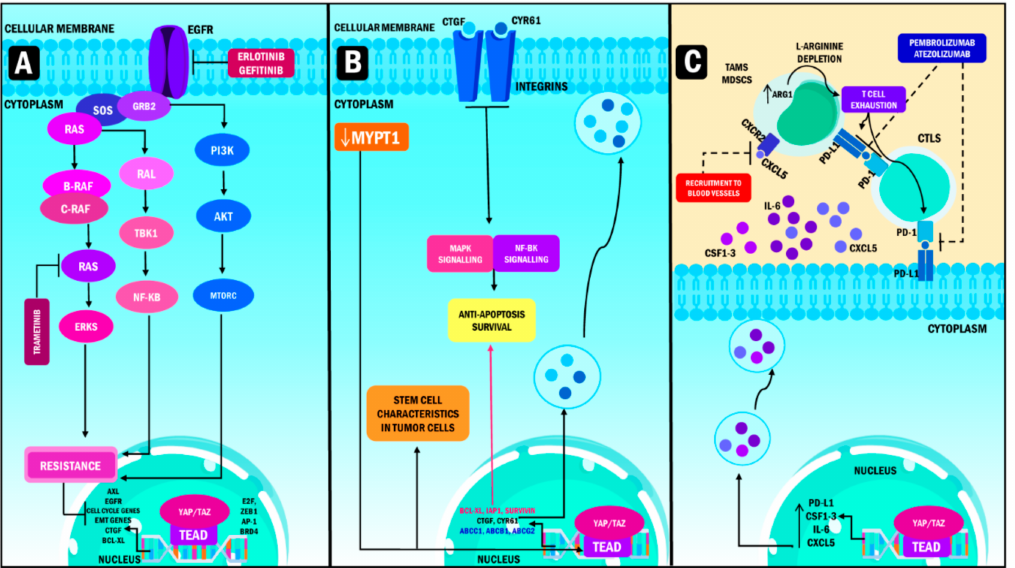
Figure 4. YAP/TAZ role in oncotherapy resistance. ( A ) Targeted therapy resistance. YAP/TAZ resistance to targeted therapy occurs mainly in EGFR and MAPK inhibitors, in non-small cell lung adenocarcinoma takes place thanks to the induction of high transcription levels of AXL. Meanwhile, YAP promotes resistance to MEK1/2 inhibition in neuroblastomas, with a hyperactive signaling of the RAS gene in cells treated with trametinib. Consequently, the overexpression of YAP produces transcription of genes that stimulate cell cycle entry, EMT, survival and cell death evasion, thus increasing resistance. ( B ) Chemotherapy resistance. The main mechanism used by YAP/TAZ to induce chemotherapy resistance is by binding to TEA domains, which produces the activation of the promoters of the Cyr61/CTGF oncogenes, causing resistance, evasion of apoptosis and hypoxia when overexpressed on the surface of tumor cells in breast cancer. In juxtaposition, the downreg- ulation of MYPT1 produces the activation of the transcriptional module of the Hippo pathway, enhancing resistance to chemotherapy and the emergence of CSC phenotypes in ovarian cancer. ( C ) Immunotherapy resistance, PD-L1, CSF1-3, IL-6 and CXCL5 transcription create an enhanced immunosuppression activity by inhibiting monoclonal antibodies whose target is PD-L1. Subse- quently, this phenomenon leads to the suppression of cytotoxic lymphocytes activity and a decrease in the production of cytokines resulting in T cell exhaustion. YAP: Yes-associated protein; TAZ: Tran- scriptional coactivator with PDZ-binding motif; TEAD: Transcriptional enhanced associate